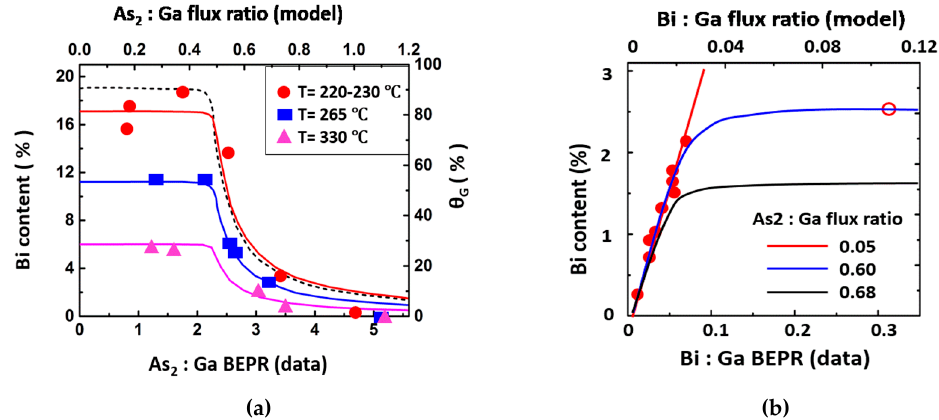
Figure 7 . ( a ) Bi content as a function of As 2 :Ga flux ratio. The solid curves are fitted based on the Lewis’ model while the broken curve is a plot of θ G for P A = 0.12 and P G = 0.001; ( b ) Bi content as a function of Bi:Ga beam equivalent pressure ratio (BEPR). Reproduced from Reference [136].